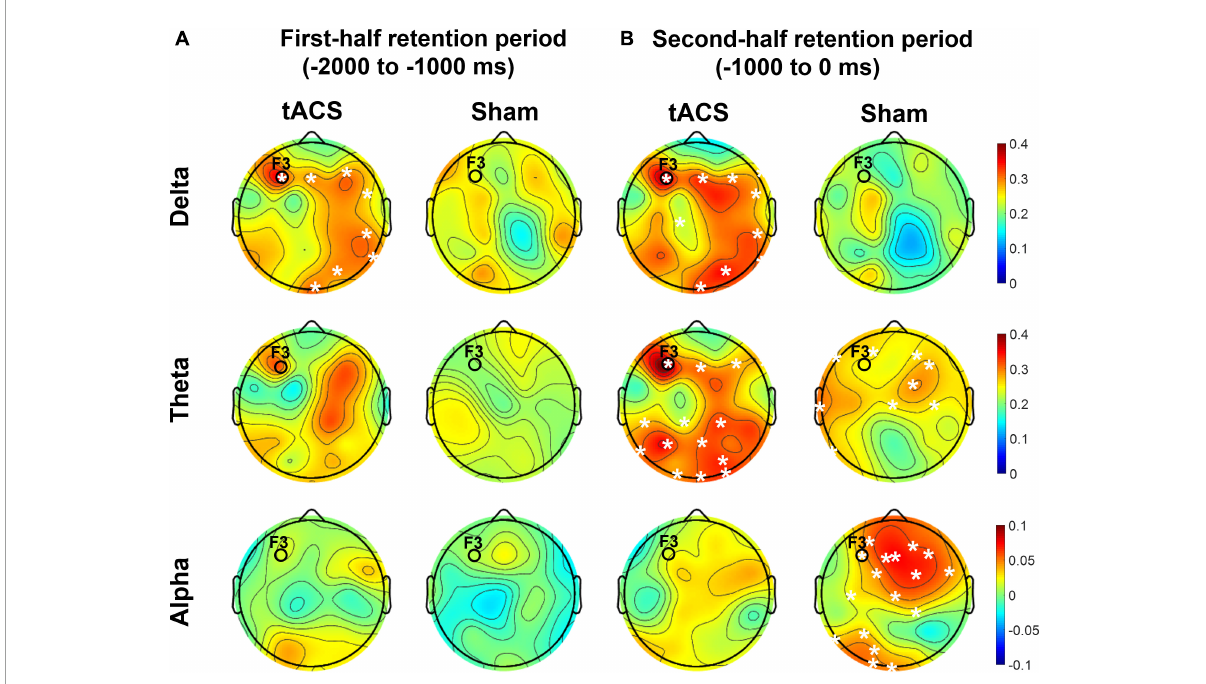
FIGURE7 Topographical distributions of the differences in nodal efficiency between pre- and post-treatment in the delta, theta, and alpha bands. The grand-averaged topographies represent the differences in nodal efficiency between pre- and post-treatment (post-treatment minus pre-treatment) during (A) the first half ( − 2,000 to − 1,000 ms before the test-stimulus presentation) and (B) the second half ( − 1,000 to 0 ms before the test-stimulus presentation) of the retention periods in both the tACS-treated and sham groups. The asterisks represent statistical significance ( p < 0.05, FDR-corrected). The electrode position for tAC stimulation (i.e., F3) is marked in each topography. The view of the topography is from the vertex, with the nose at the top of the